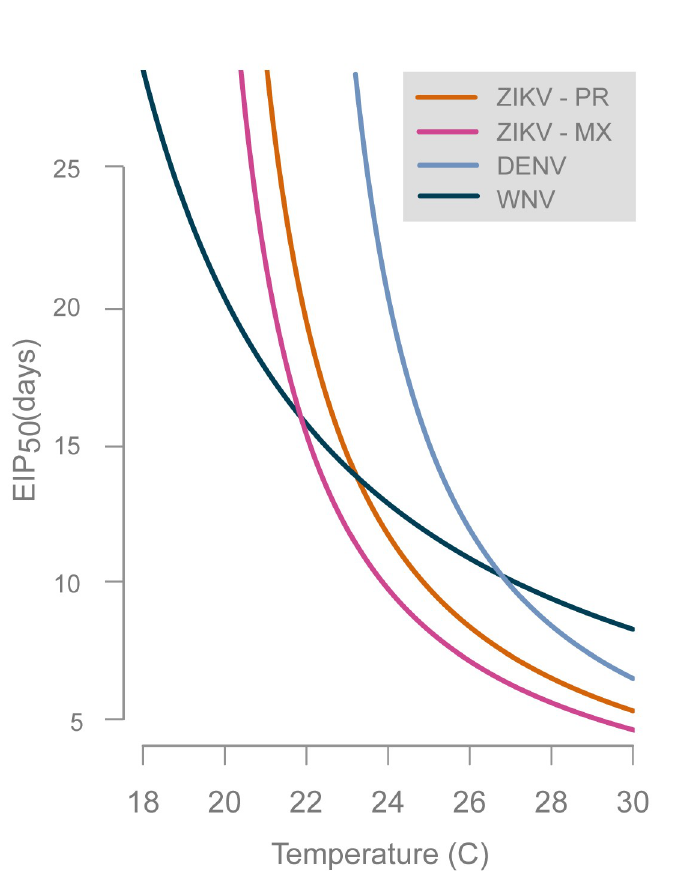
Fig 5. Fitted curves showing the median EIP of the flaviviruses ZIKV, dengue virus (DENV), and West Nile virus (WNV) over a range of temperatures. ZIKV–PR is the Puerto Rico strain used in this study, whereas ZIKV–MX is a Mexican strain used by Tesla et al.